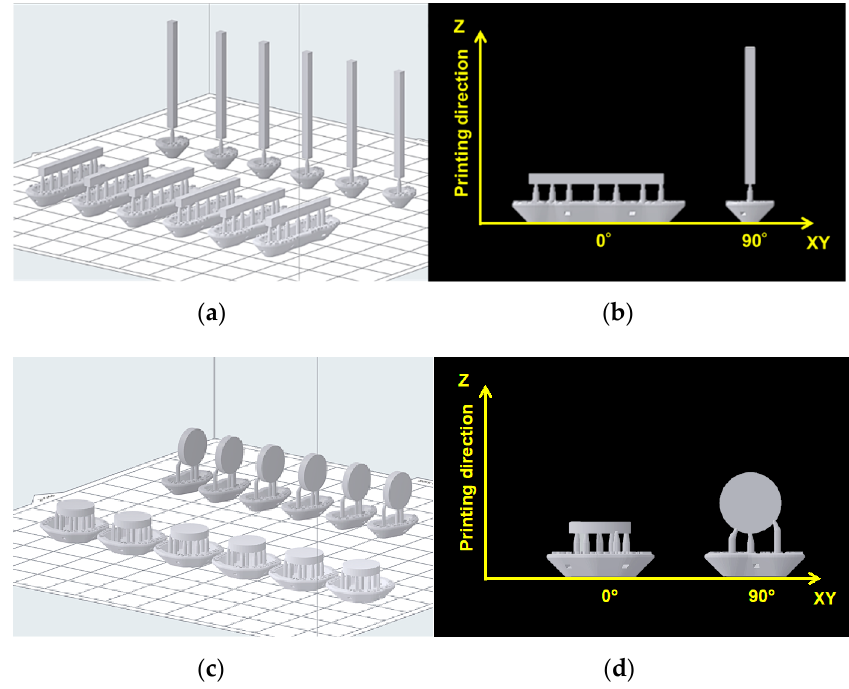
Figure 4. Specimens being 3D-printed in two directions: ( a ) and ( c ) STL data imported to the 3D printing software (n = 6); ( b ) and ( d ) print layer perpendicular to the loading direction (0°) and software (n = 6); ( b , d ) print layer perpendicular to the loading direction (0 ◦ ) and parallel to the parallel to the loading direction (90°). loading direction (90 ◦